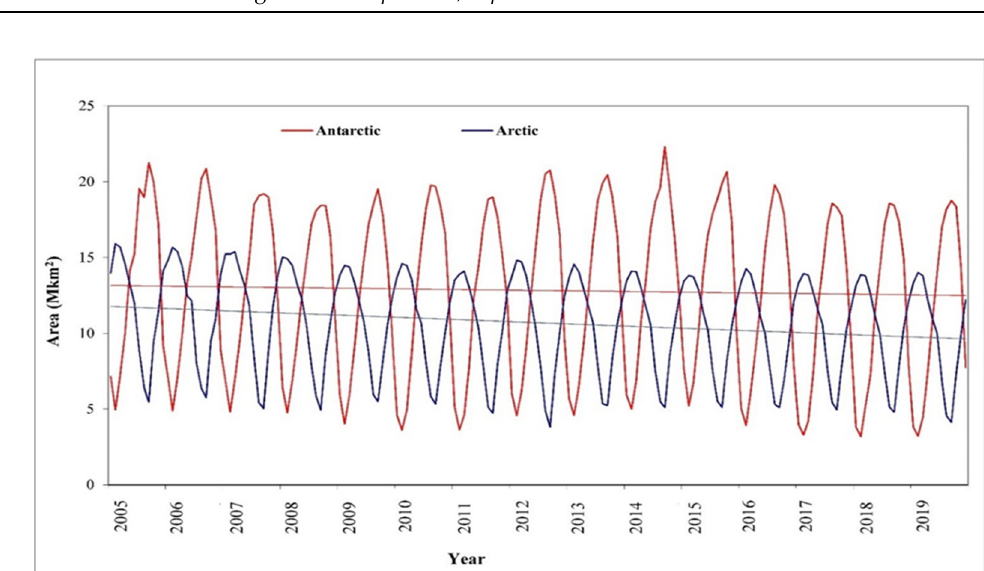
Figure 4. Annual changes in ice sheet area over the Arctic and Antarctic regions during the 2005– 2019 period.